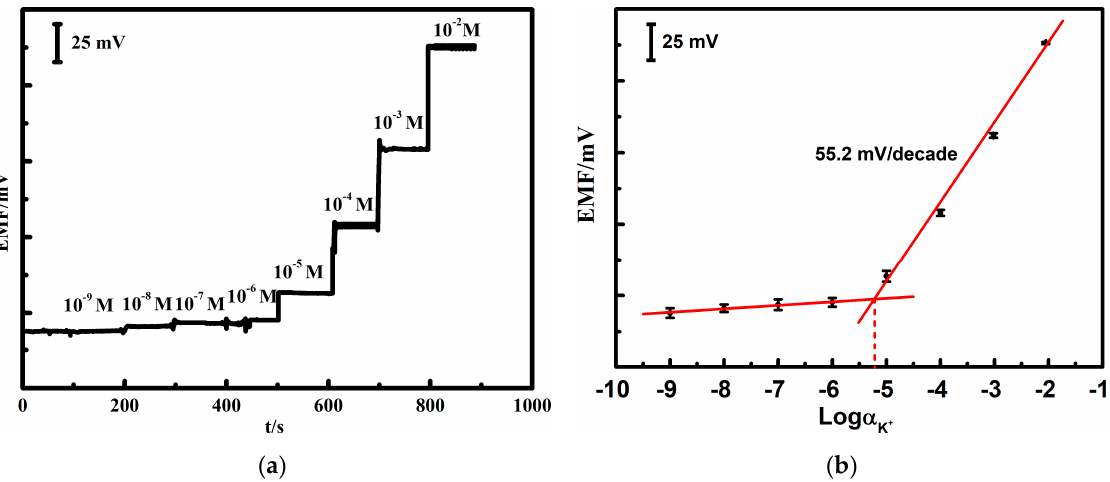
Figure 2. ( a ) Open-circuit potential responses of different K + concentrations; ( b ) calibration curve of GC/MoS 2 /Fe 3 O 4 /K + - ISE.